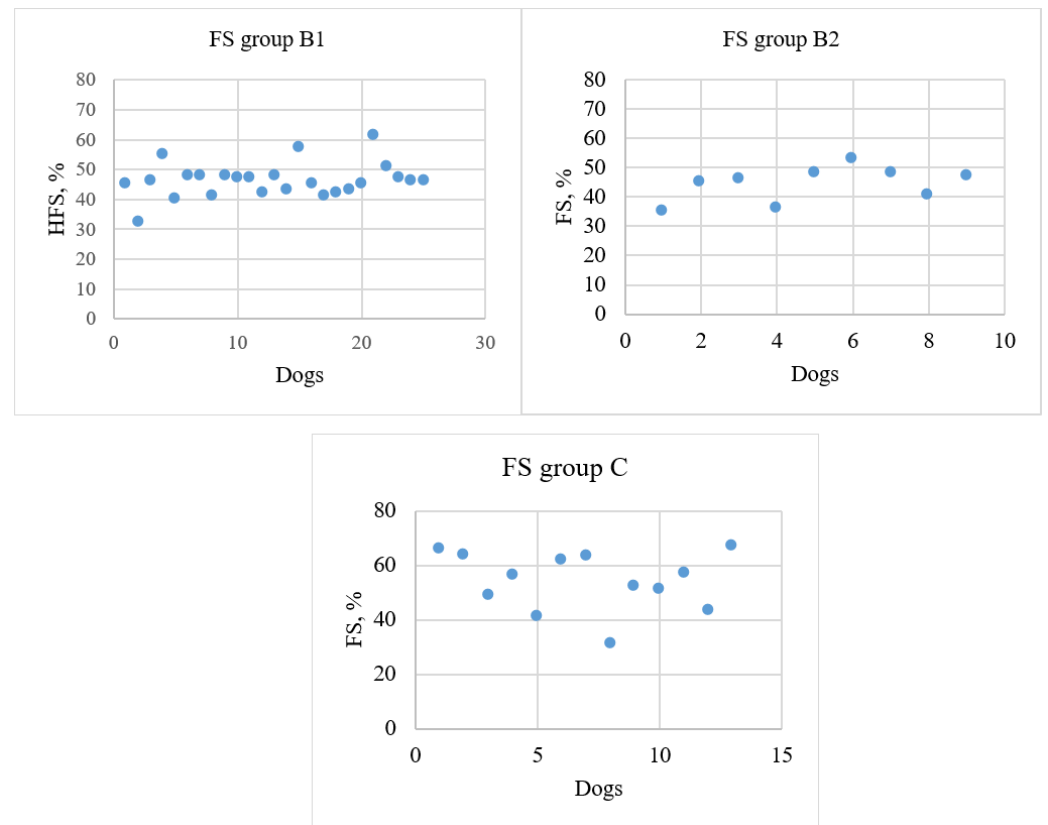
Fig. 3 . Spot diagram of the FS values of experimental animals with the progression of MMVD